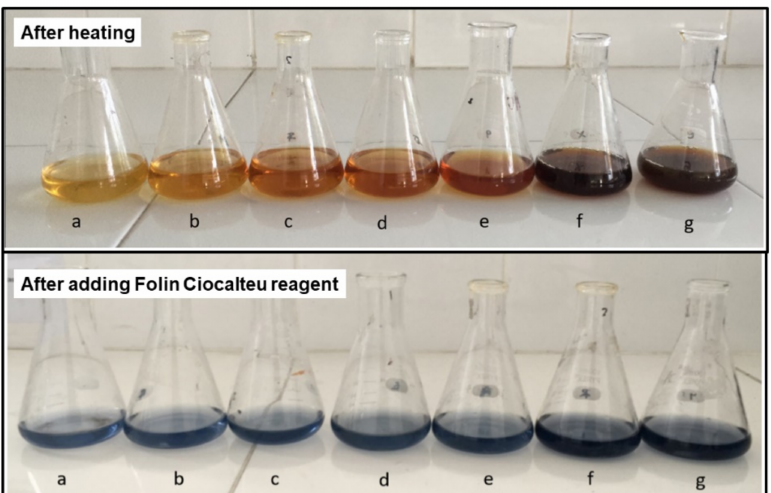
Figure 1. Tea extract after heating for 20 min and after the addition of Folin Ciocalteu reagent at: ( a ) 28; ( b ) 50; ( c ) 60; ( d ) 70; ( e ) 80; ( f ) 90; and ( g ) 98 ◦